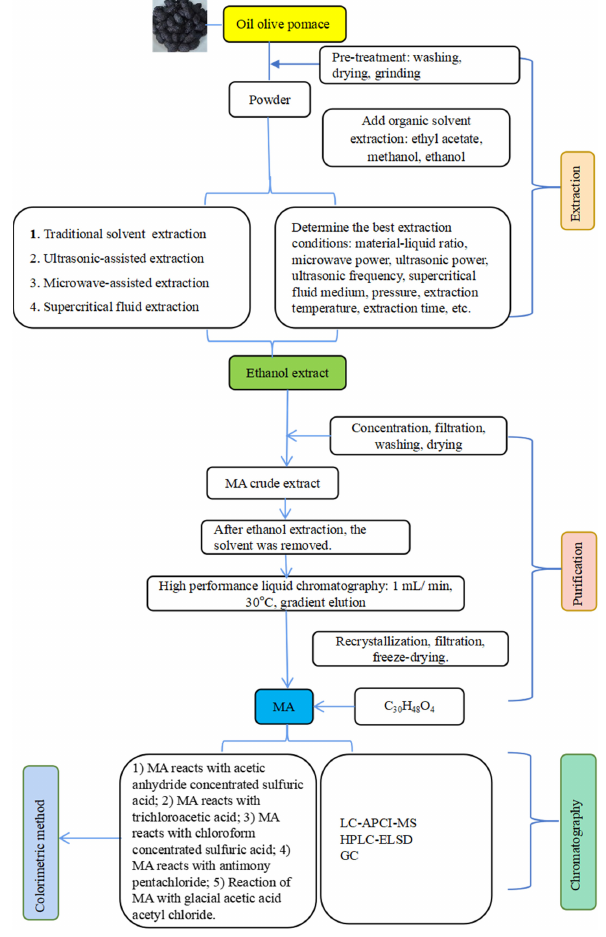
Figure 2. Extraction, purification and identification of MA.